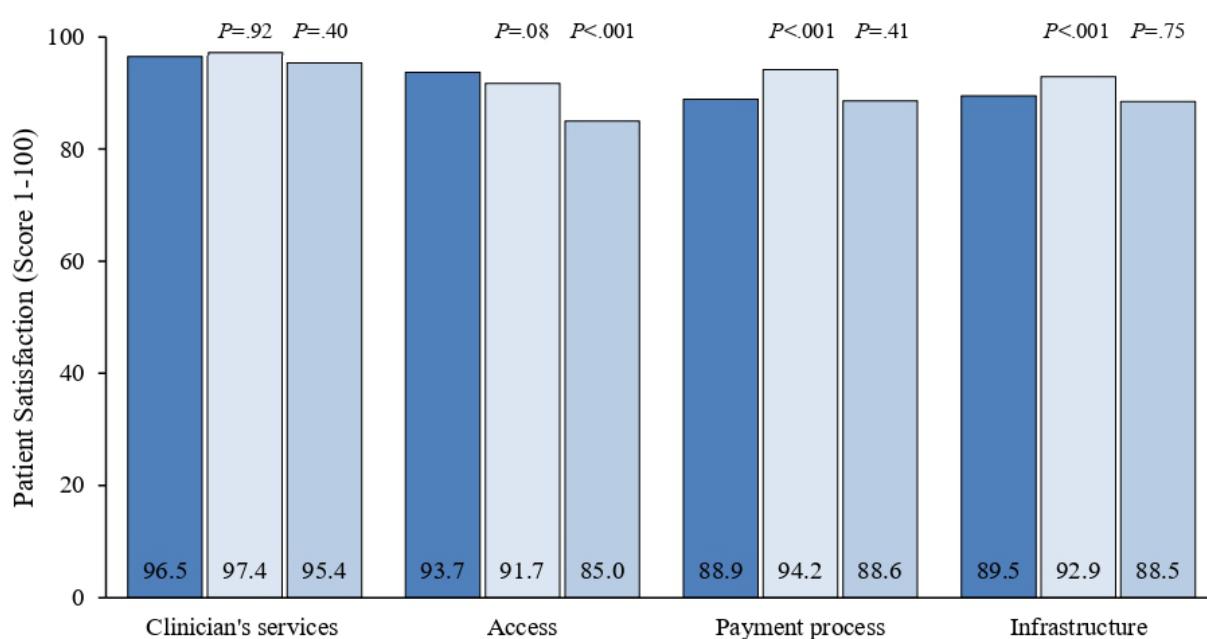
Figure 3. Satisfaction of patients receiving care via telemedicine compared to concurrent and retrospective control